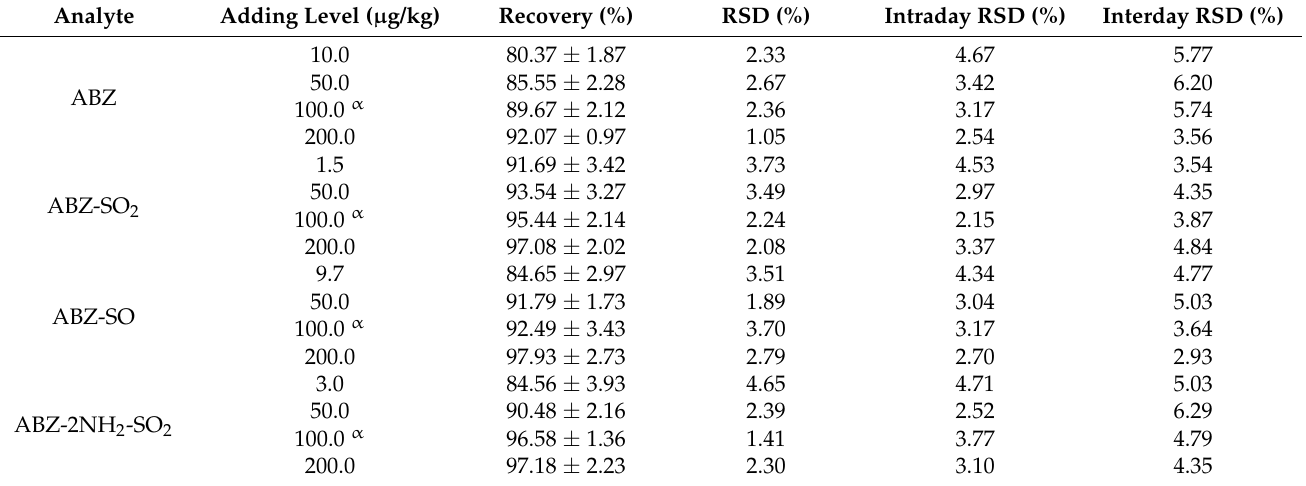
Table 3. Recovery and precision of ABZ, ABZ-SO 2 , ABZ-SO and ABZ-2NH 2 -SO 2 added to blank pig muscle (n = 6).